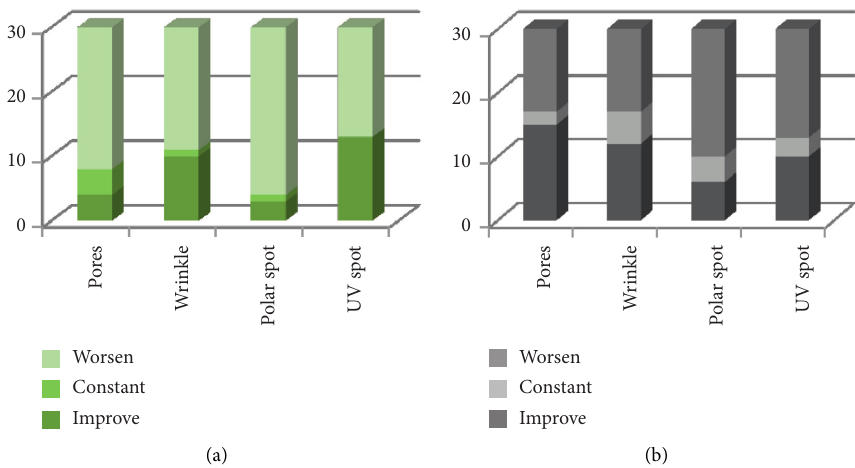
Figure 3: A comparison of the first and third observations between the control (a) and treatment (b) groups.